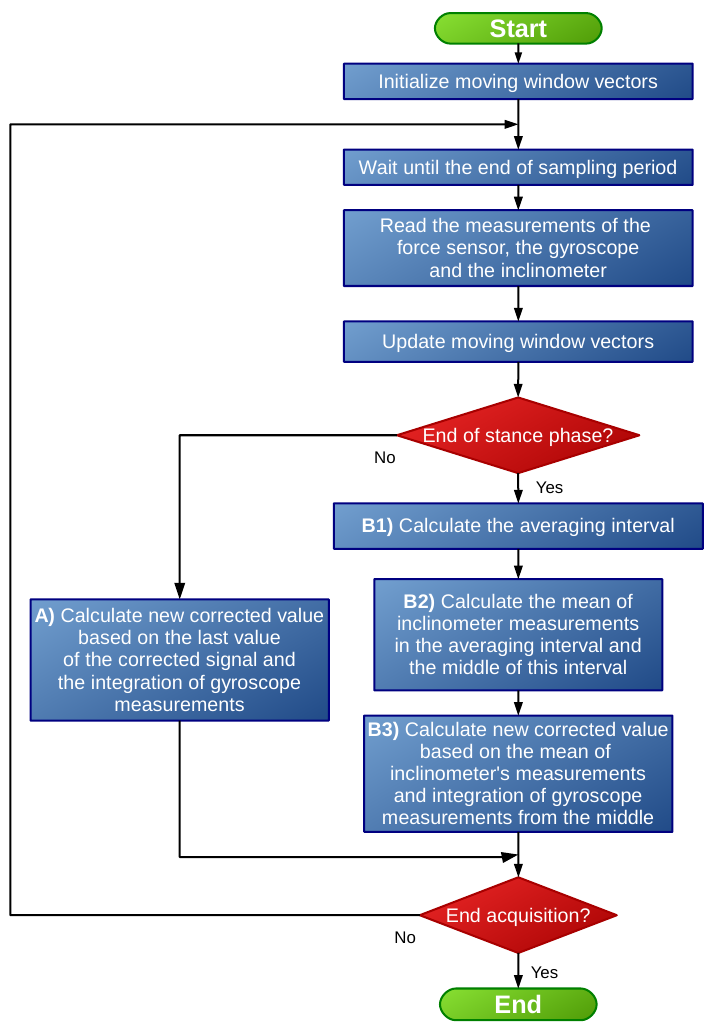
Figure 8. Block diagram of the algorithm used to estimate the pitch angle of the